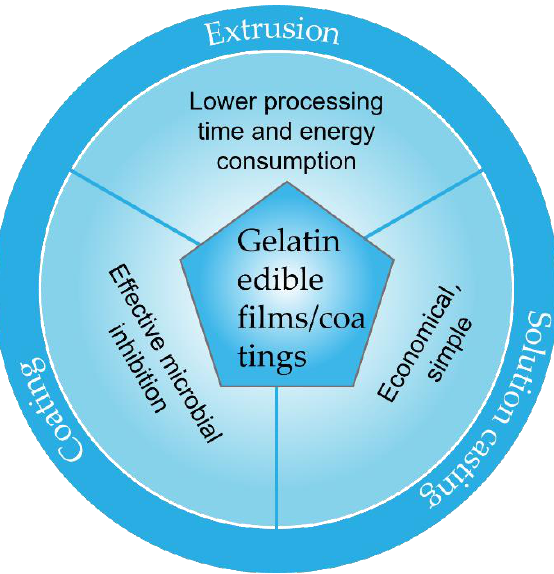
Figure 4. Common techniques for producing edible films and coatings.